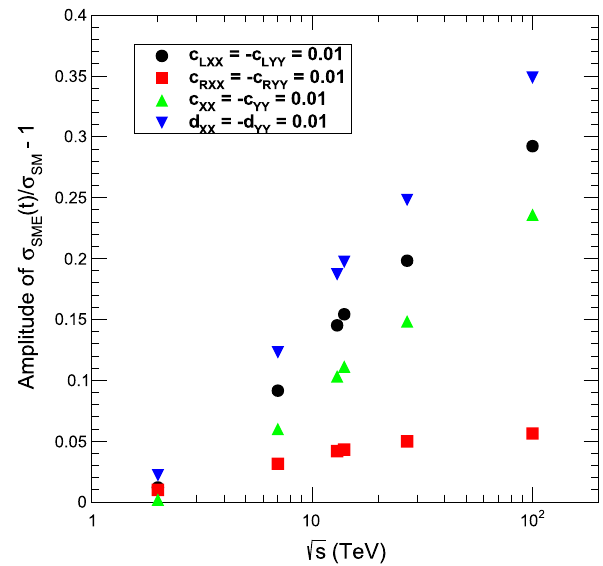
Fig. 1 Amplitudeof f ( t ) = σ SME /σ SM − 1inp–pcollisionsatcenter- of-mass energies corresponding to Tevatron, LHC, HL-LHC, HE-LHC and FCC energies, using CMS location as laboratory frame, shown for the c XX = − c YY = 0 . 01